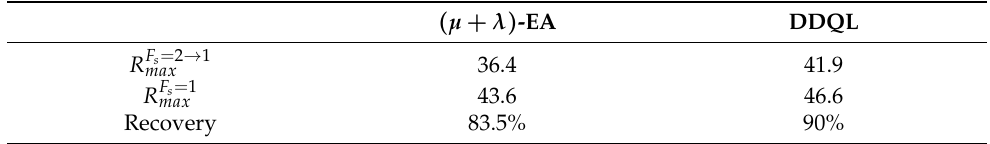
Table 9. Experiments results for multi-agent case in EA and DDQL algorithms when optimizing with N = × 2 and the agent starting from position 2 is not available for the